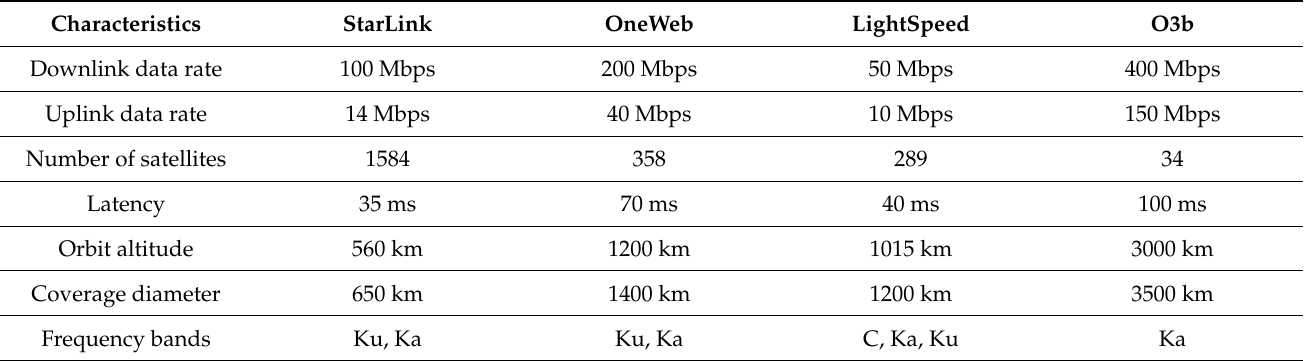
Table 1. Current and Planned non-GSO systems.